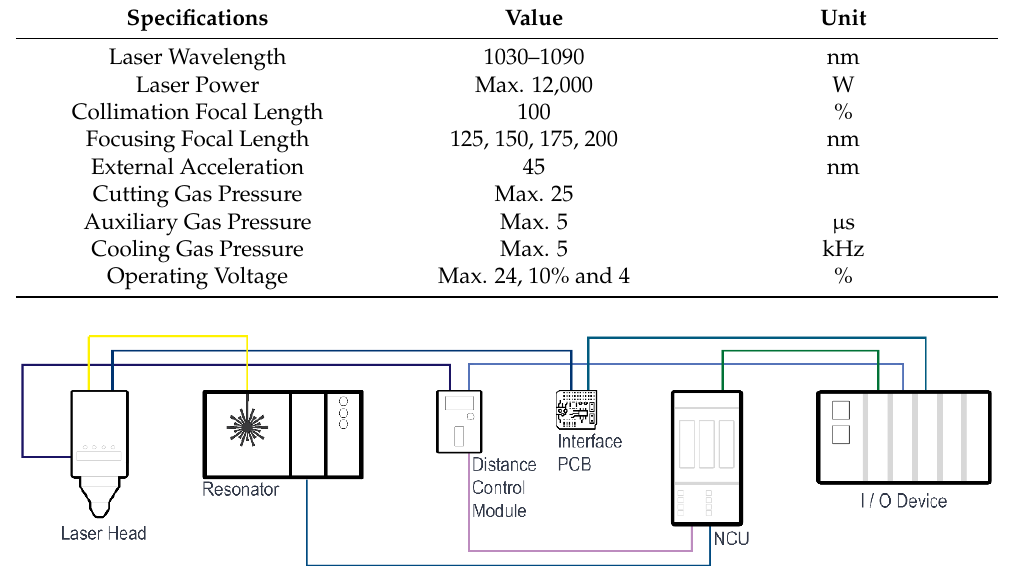
Figure 1. Schematic diagram of equipment used for tests.